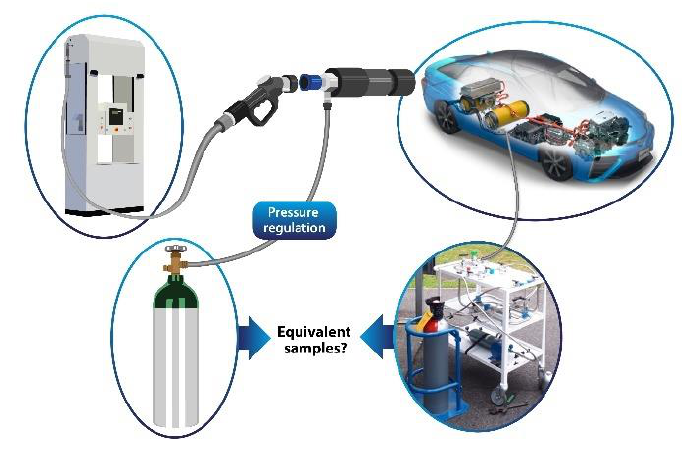
Figure 1. Schematic of the comparison principles between HRS nozzle sampling and FCEV sampling to evaluate the representativity of the sample taken by the FCEV sampling system.